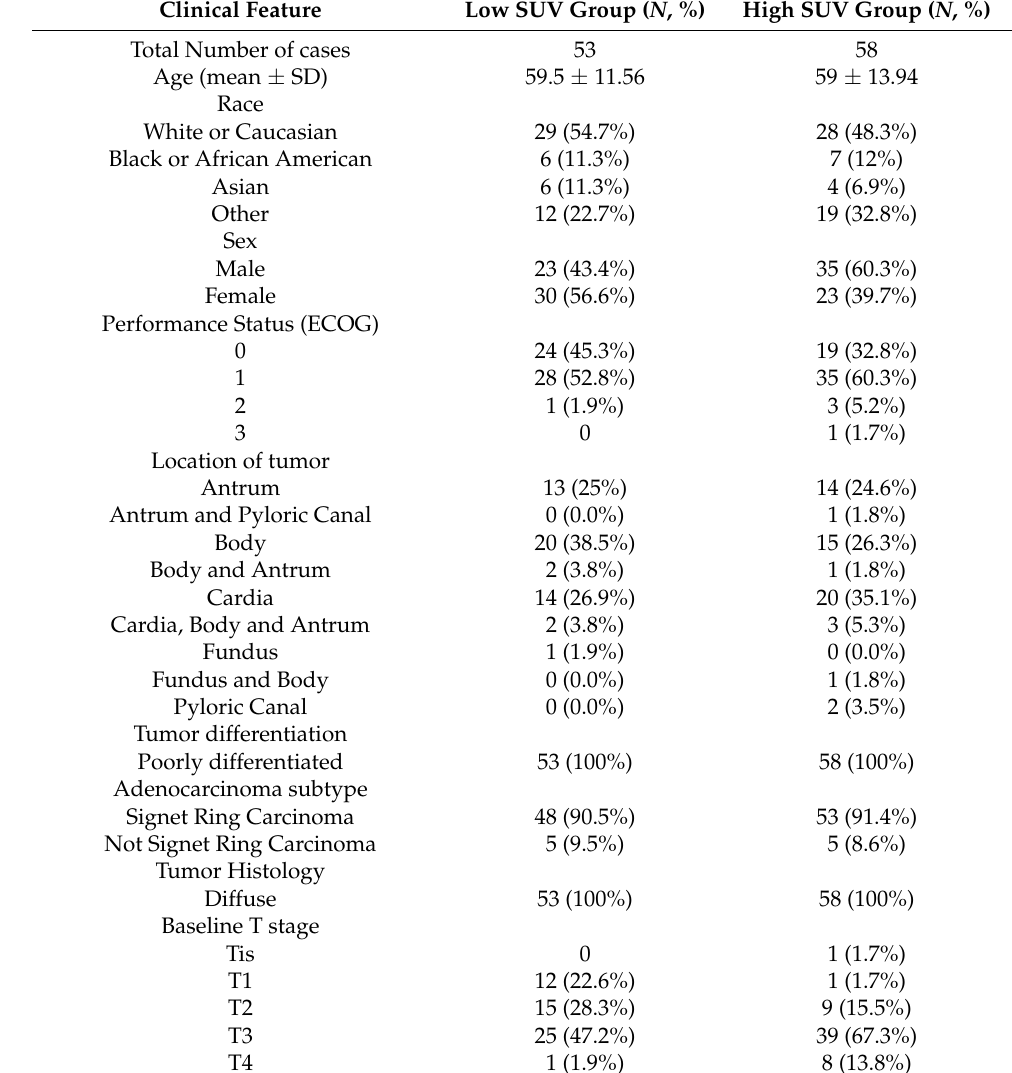
Table 1. Demographic and clinical characteristics of